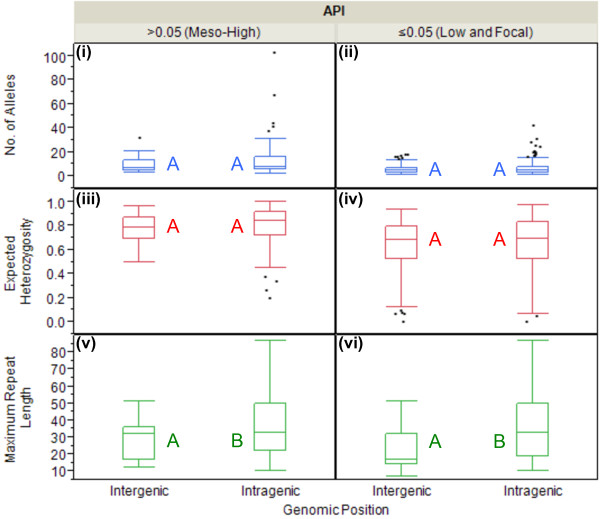
Genomic position as a function of MS diversity. For all MS markers combined, the box plots compare the mean number (no) of alleles per locus (y-axis, blue), expected heterozygosity (He) (y-axis, red) and maximum repeat length (y-axis, green) across different genomic positions (x1°-axis), stratified API (x2°-axis). Character values (A and B) denote statistical significance between intergenic and intragenic locations, within each API category. For the both API strata, there were no significant differences among the mean no of alleles (panels i, ii) per locus or mean He(panels iii, iv) between intergenic and intragenic regions. In both API strata, API ≤0.05 (panel vi) and API >0.05 (panel v), the mean maximum repeat length did vary significantly between intergenic and intragenic, with intragenic loci having significantly higher numbers of repeats than intergenic regions (p <0.0001 and p = 0.0303 for API ≤0.05 and API >0.05, respectively, ANOVA).